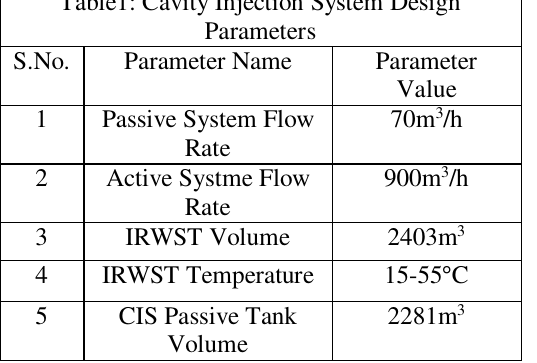
Table1: Cavity Injection System Design Parameters